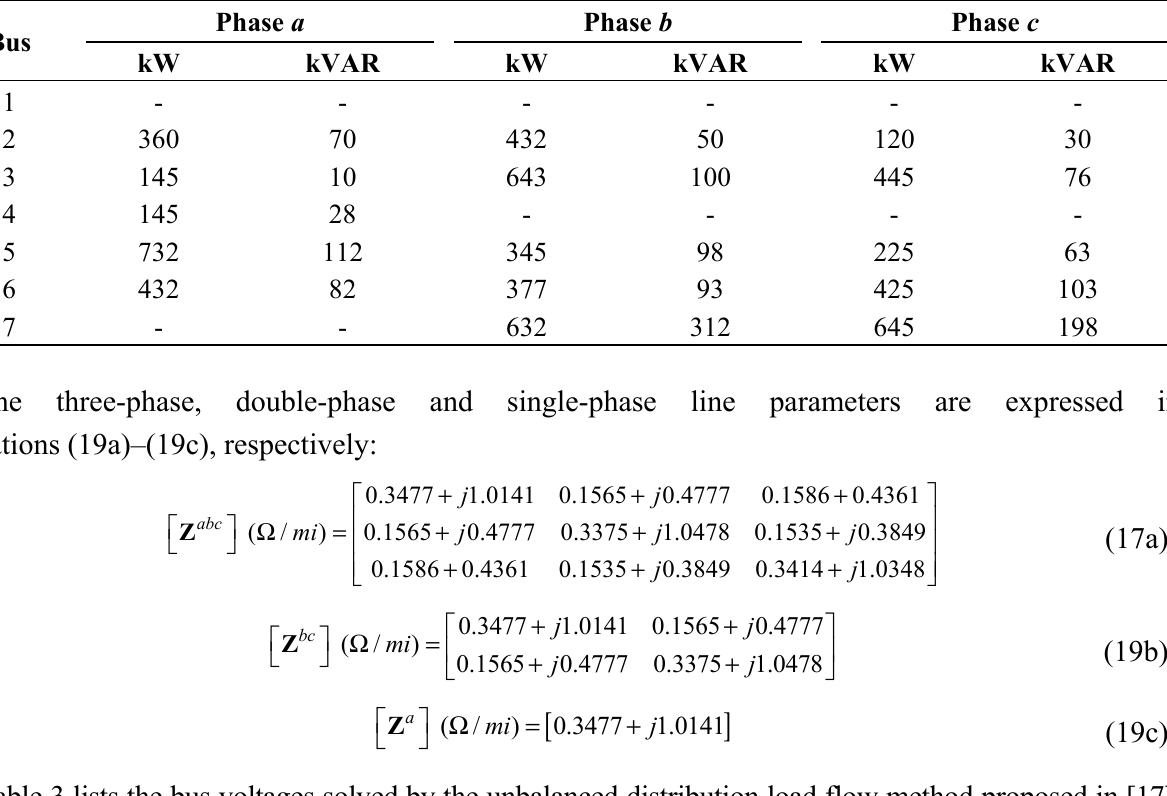
Table 2. Load data of a simple seven-bus test system.